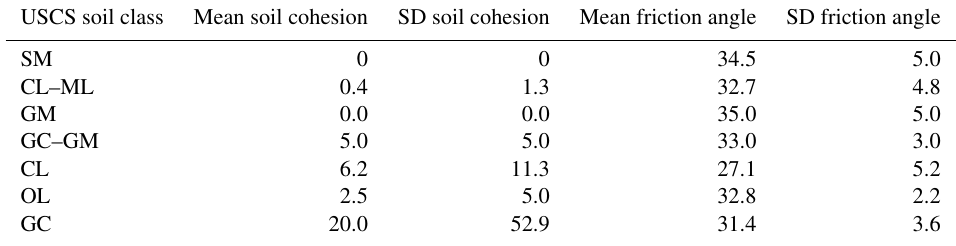
Table A1. The hybrid table for the soil cohesion and angle of internal friction for the relevant set of USCS soil classes. Values are derived from laboratory experiments (VSS-Kommission, 1998; Dysli and Rybisar, 1992) and combined in this research to exclude values that seem